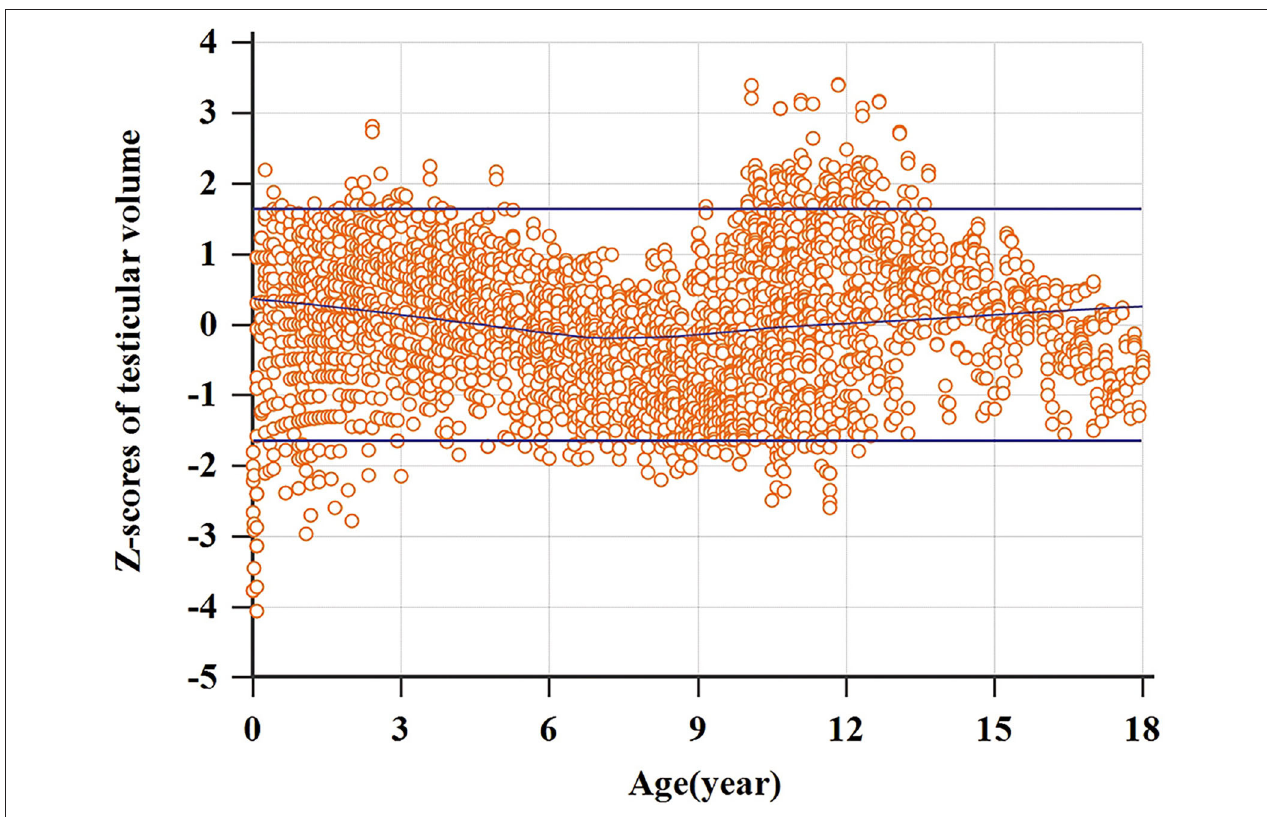
FIGURE 5 | Diagram of Z score